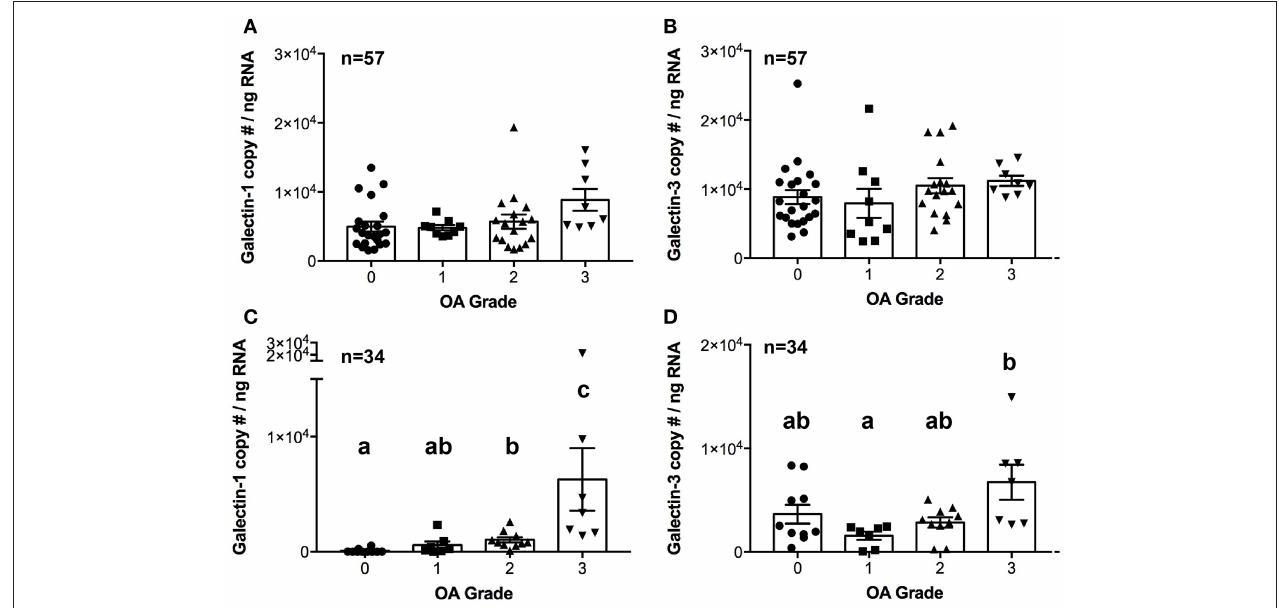
FIGURE 3 | Galectin-1 and-3 copy # per ng of RNA from synovial membrane (A,B) or cartilage (C,D) tissue obtained from healthy carpal joints (0) or carpal joints with naturally occurring osteoarthritis (1–mild, 2–moderate, 3–severe OA). There were no differences in galectin-1 or-3 mRNA expression in synovial membrane tissue (A,B) . Cartilage galectin-1 mRNA expression increased with OA severity score ( C , P = 0.0002), whereas galectin-3 mRNA expression was increased in severe OA cartilage as compared to mild OA cartilage ( D , P = 0.03). Scatterplots are displayed, with bars representing mean ± S.E.M. Differing letters note statistically significant differences, P <